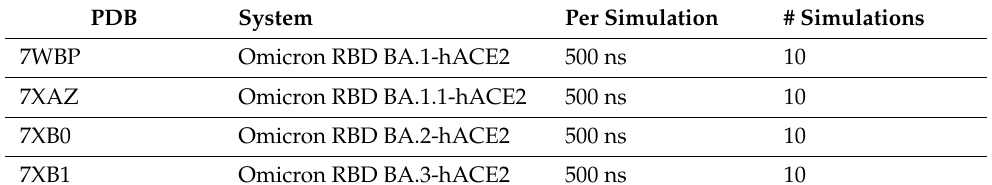
Table 2. Structures of the Omicron RBD-hACE2 complexes examined in this study.